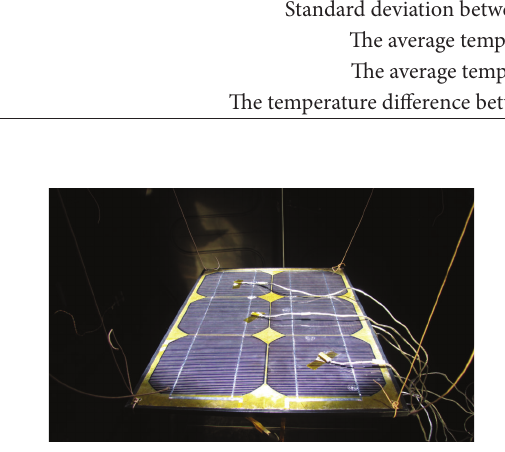
Figure 4: Test specimen temperature test.